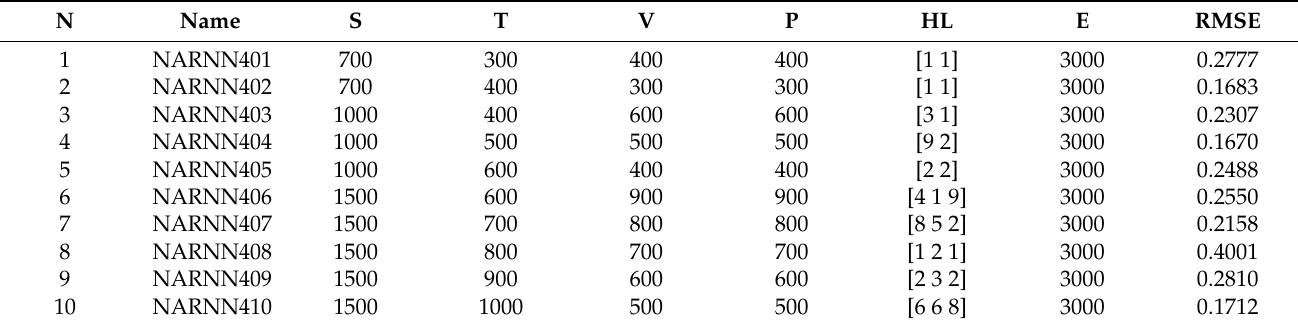
Table 2. Results of non-optimized